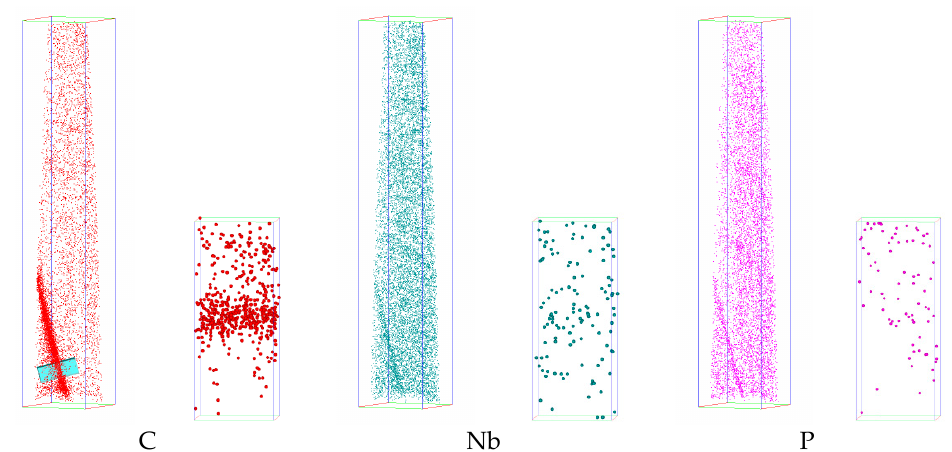
Figure 4. Three-dimensional elemental maps of the box (54 nm × 54 nm × 298 nm) containing grain boundary and magnified maps of enriched atoms across the boundary.